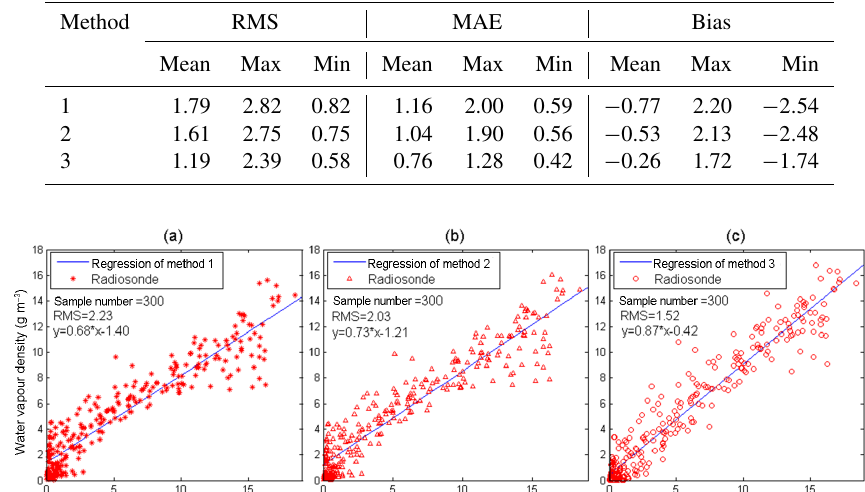
Table 4. Statistical result of RMS, MAE, and bias for three tomographic methods at heights from 0 to 8 km in the experiment (gm − 3 ) .